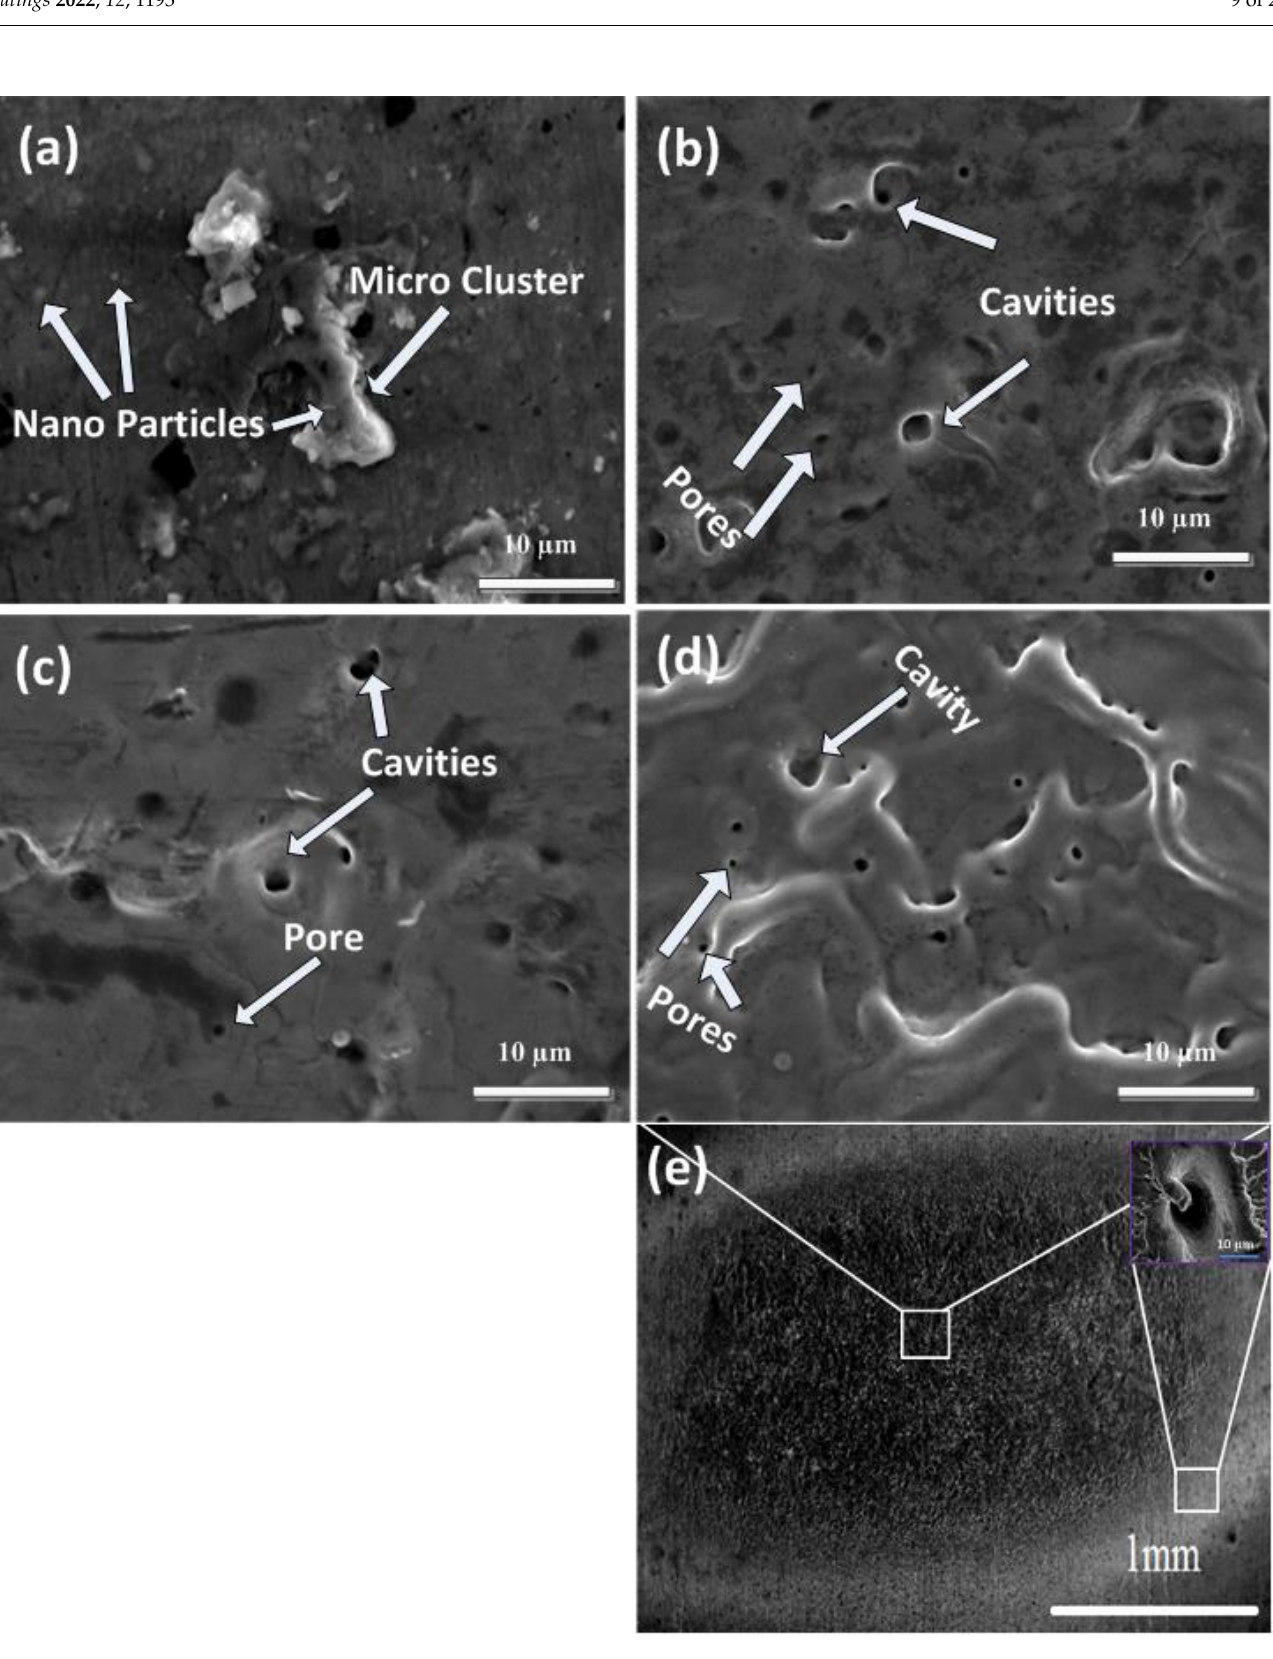
Figure 3. SEM images of central ablated areas of Cd targets exposed to ( a ) 500, ( b ) 1000, ( c ) 1500, and ( d ) 2000 laser pulses, and ( e ) show the full view of ablated region for 2000 laser pulses, at constant fluence value of 3.6 Jcm − 2 in ethanol.